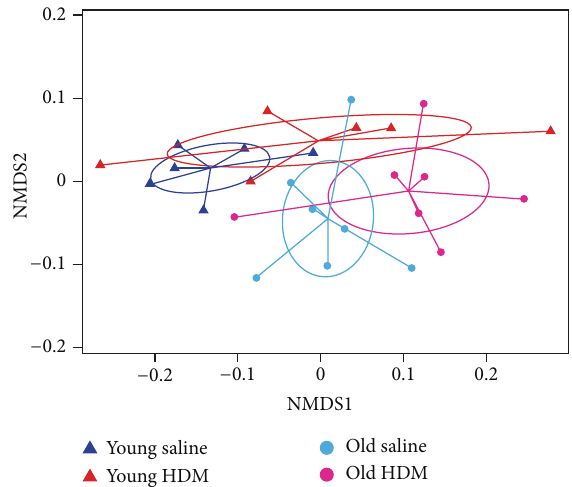
Figure 4: Nonmetric multidimensional scaling (NMDS) of bacterial communities. Saline mice (young: dark blue and old: light blue) and HDM mice (young: red and old: pink) are shown. Both age ( 𝑝 < 0.01 ) and HDM exposure ( 𝑝 < 0.05 ) significantly influenced community structure based on permutational ANOVA analysis. Ellipses represent the 95% confidence interval on standard errors of